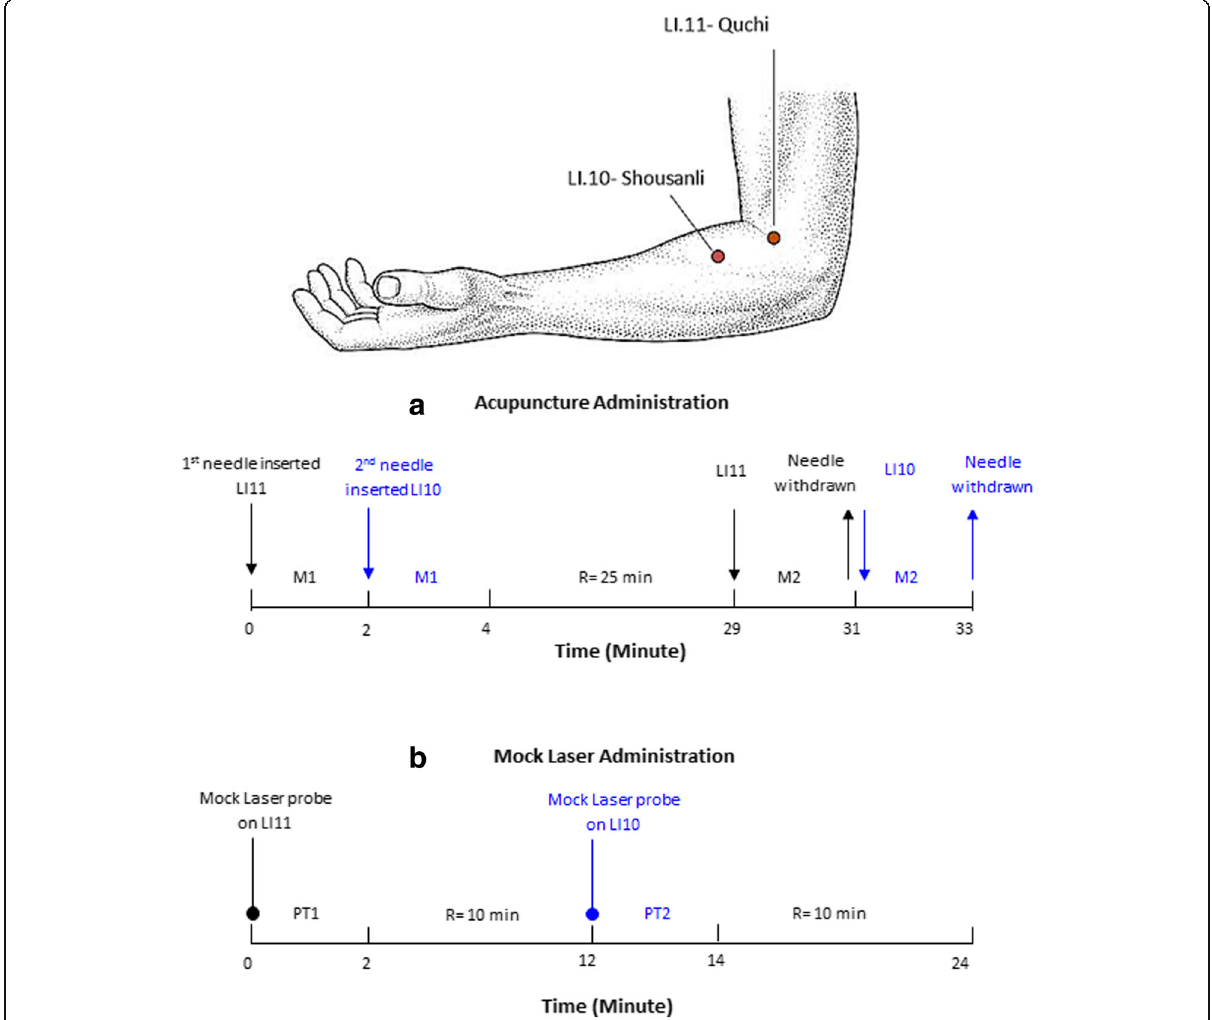
Fig. 2 a indicated the manual needle manipulation at acupoint LI11 followed by LI10 on the affected side. First time Manipulation (M1); Second time Manipulation (M2); Rest period (R). b indicated the use of inactive mock laser probe on the same acupoints to acupuncture group at different time interval; First time Probe Touch (PT1); Second time Probe Touch (PT2); Rest period